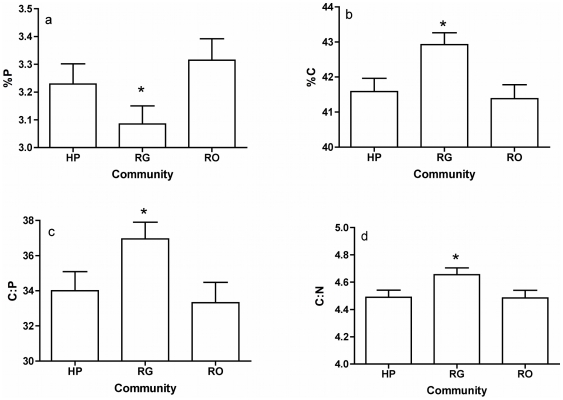
The effect of community composition (i.e. life history phenotype) on the elemental stoichiometry of adult Rivulus hartii.Fish community composition predicts life history phenotype of this species, as well as a small component of its elemental composition and organismal stoichiometry. Bars are least squares means (standard error) of elemental composition and elemental stoichiometry generated from a general linear model (Table 3). They are standardized to body size = 35 mm. Community designations are RO = Rivulus Only, RG = R. hartii and Guppies, HP = High Predation sites. Bars surmounted by a star are significantly different using Tukey post hoc HSD test at P<0.05.